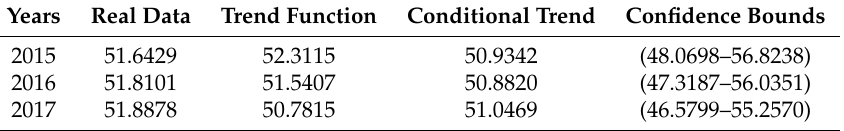
Table 2. Predictions with trend function (TF) and conditional trend function (CTF) of the process. Years Real Data Trend Function Conditional Trend Confidence Bounds